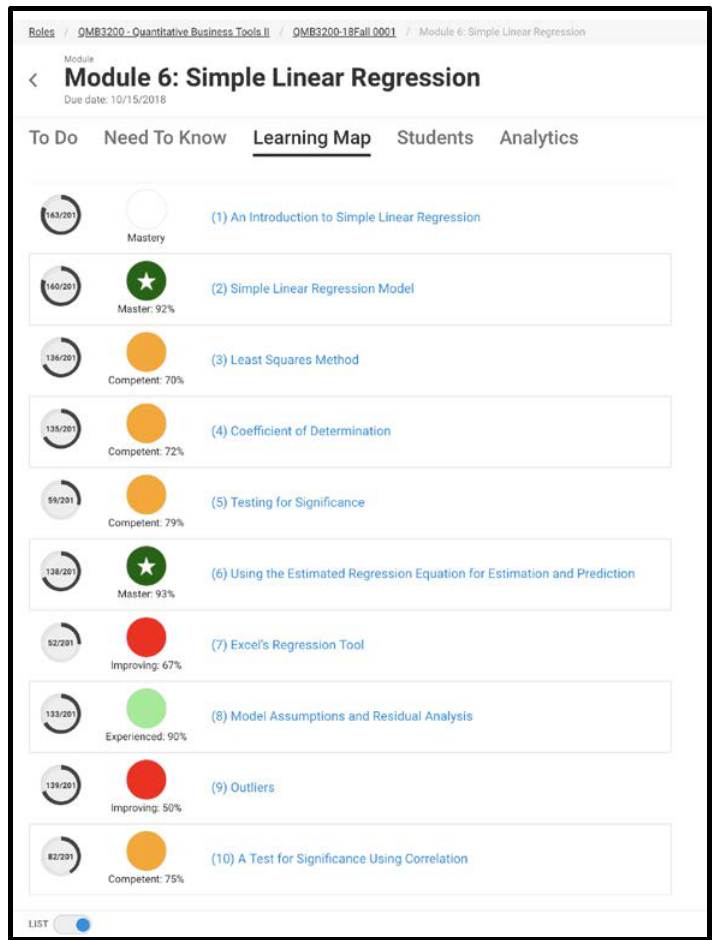
Figure 3. Ten lessons associated with the objective on the topic of Simple Linear Regression. Adapted from QMB3200: Quantitative Business Tools II, by T. Buhagiar, 2018, Orlando, FL: University of Central Florida. Copyright 2018 by the University of Central